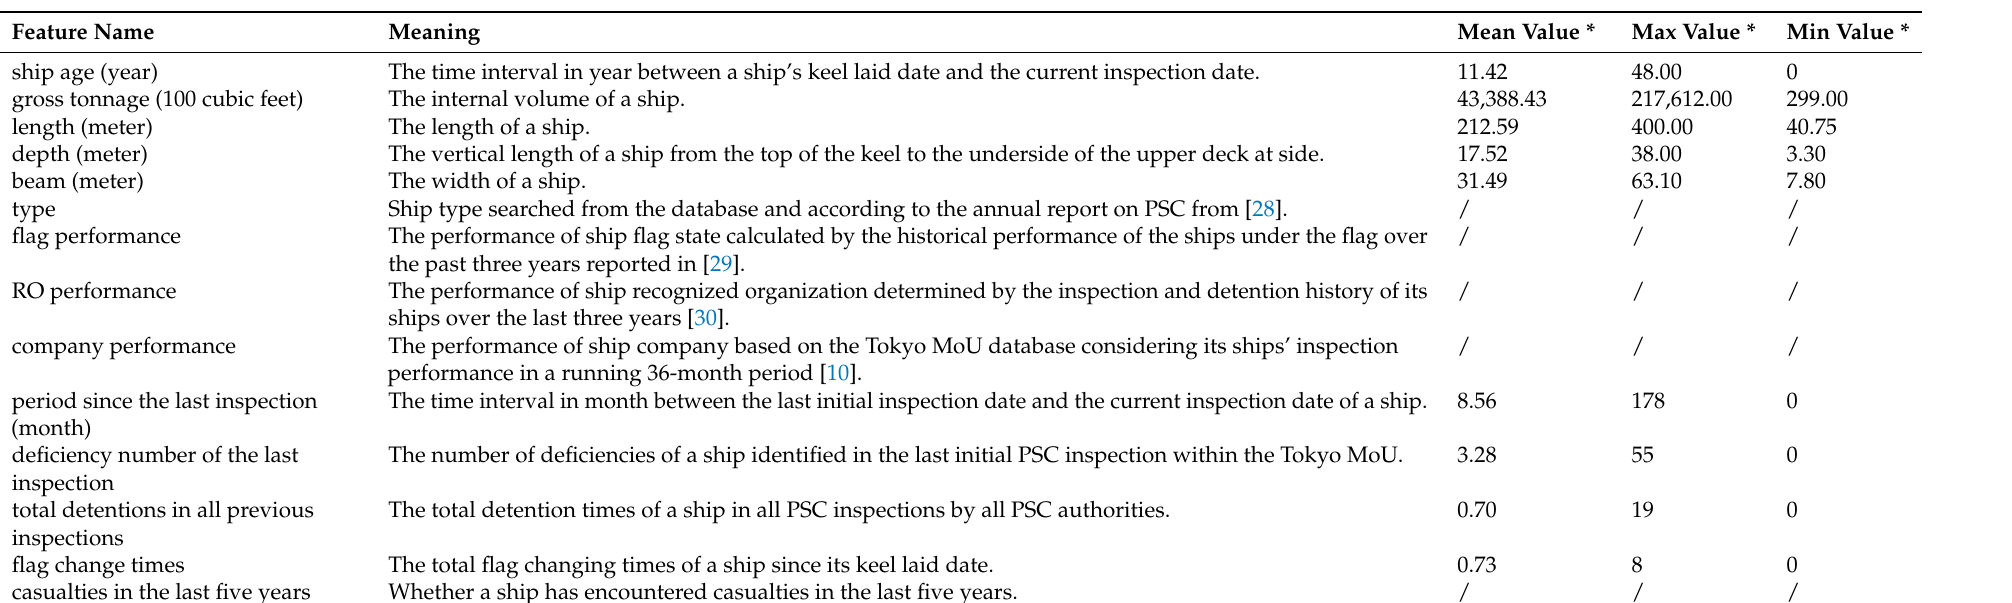
Table 2. Feature explanation and descriptive